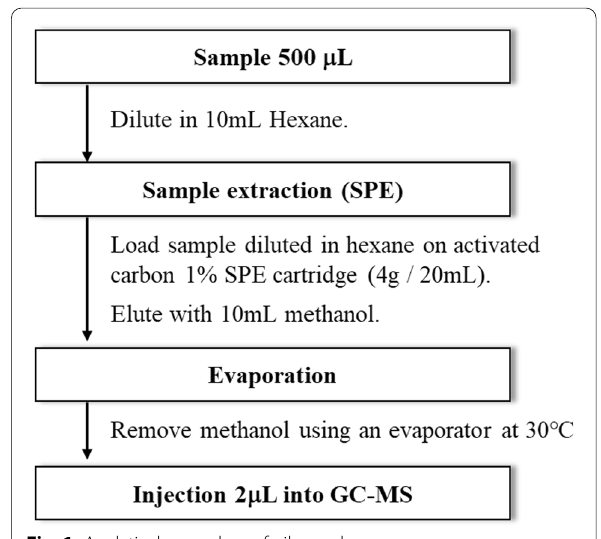
Fig. 1 Analytical procedure of oil